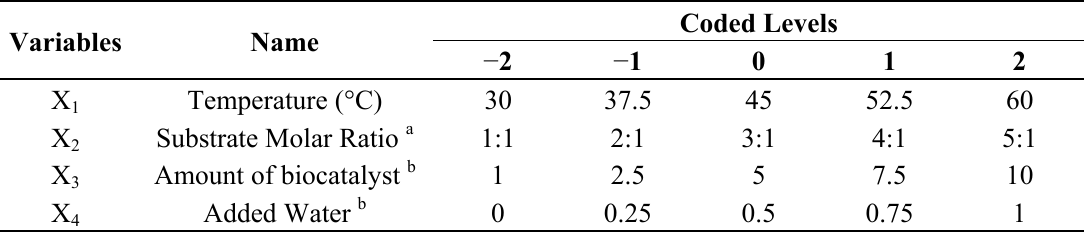
Table 3. Process variables and their levels used in